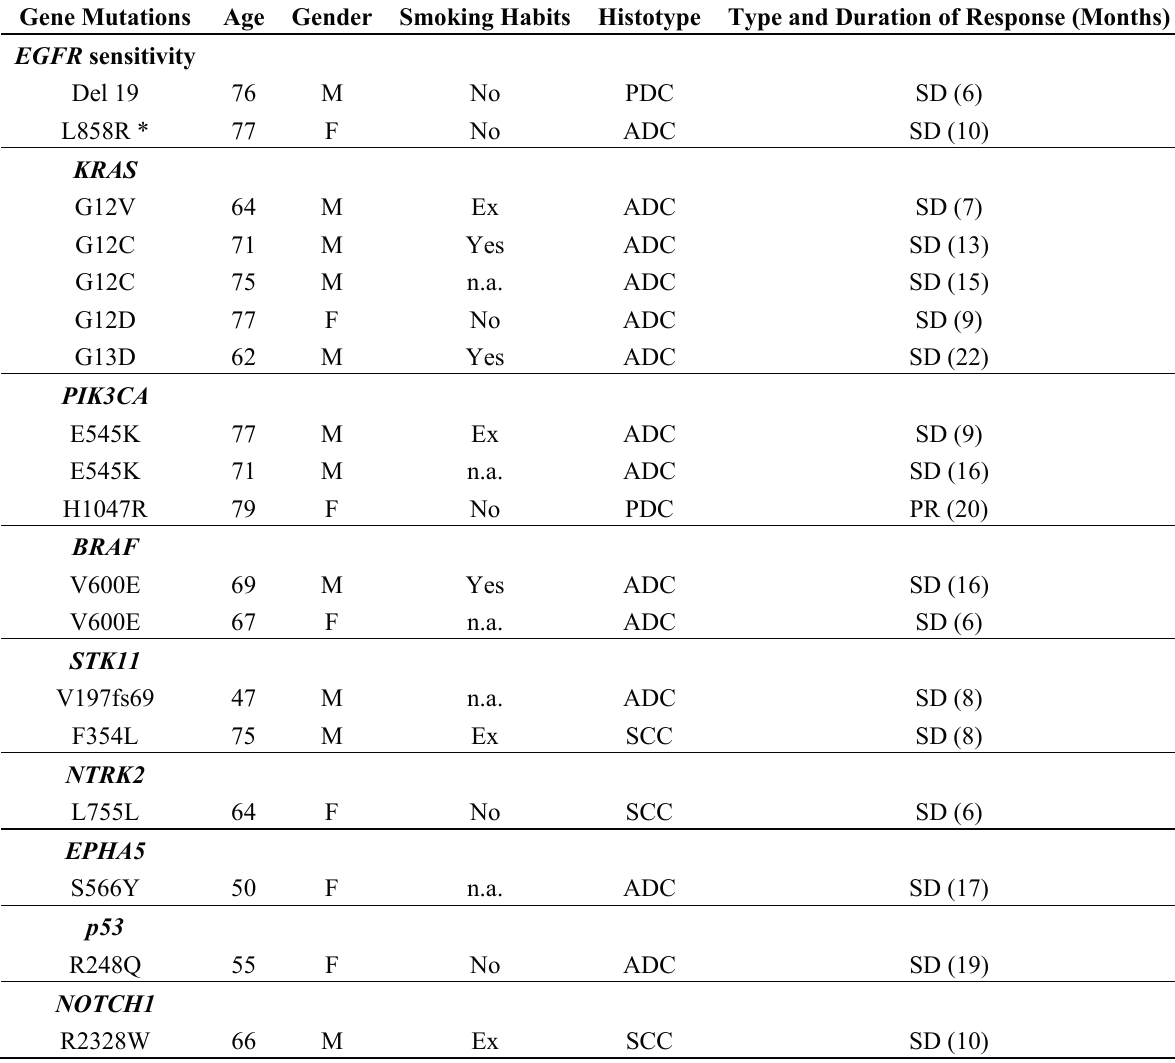
Table 3. Clinical-pathological characteristics and type of response in mutated responder patients. Gene Mutations Age Gender Smoking Habits Histotype Type and Duration of Response